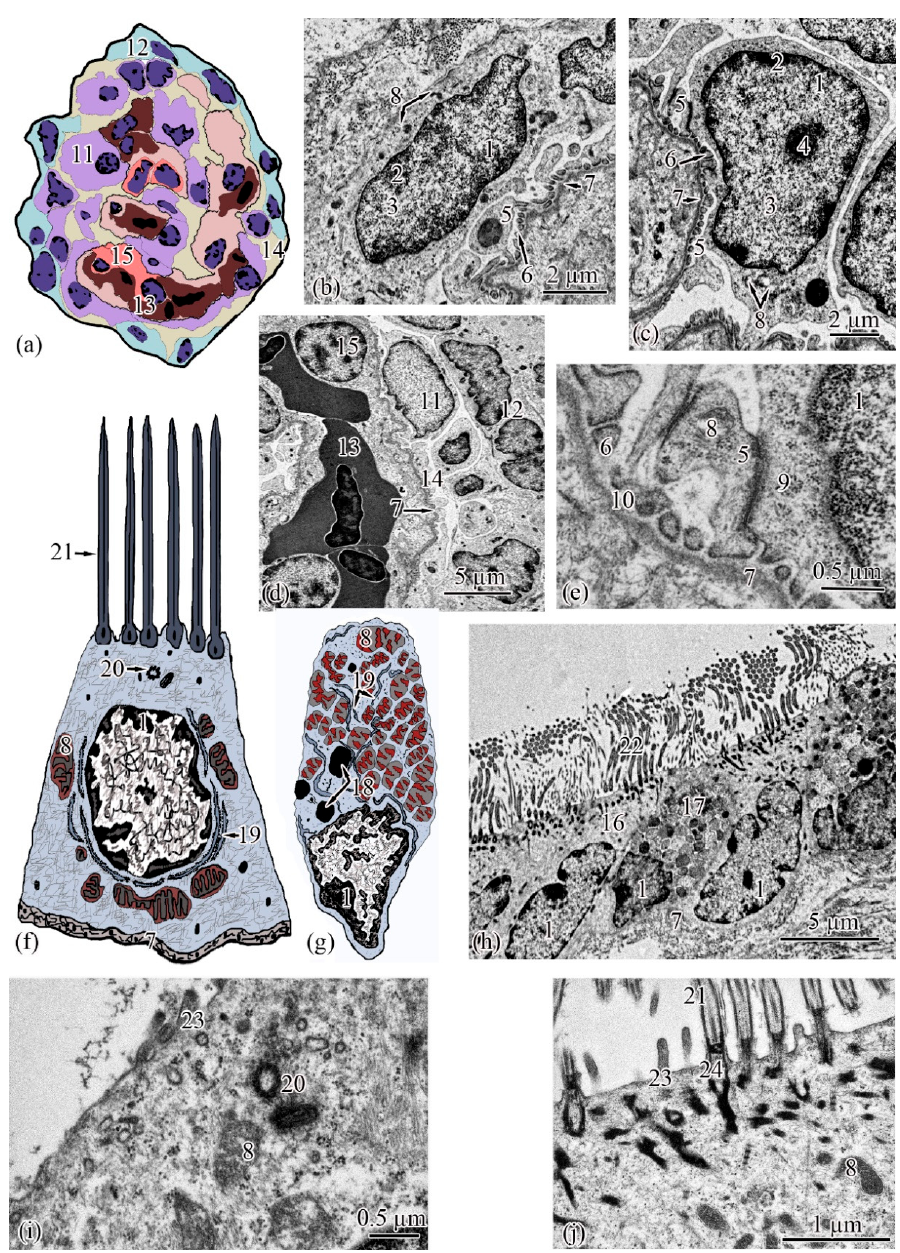
Figure 3. Ultrastructure of the renal corpuscle end of the neck segment. Renal corpuscle scheme ( a ); squamous epithelial cell of the parietal layer of the Bowman’s capsule ( b ); podocyte ( c ); part of the renal corpuscle ( d ); part of the podocyte ( e ); ciliated epithelial cell scheme ( f ); intercalated epithelial cell scheme ( g ); part of the neck segment ( h ); basal part of ciliated epithelial cell ( i , j ). Cell units: nucleus (1), heterochromatin (2), euchromatin (3), nucleolus (4), cytotrabecula (5), cytopodia (6), basement membrane (7), mitochondria (8), ribosomes (9), filtration slit (10), podocyte (11), squamous epithelial cell (12), glomerular capillary (13), urinary space (14), endothelial cell (15), ciliated epithelial cell (16), intercalated epithelial cell (17), secretory granules (18), smooth endoplasmic reticulum (19), centrioles (20), cilia (21), brush border (22), microvilli (23), basal body of the cilium (24).